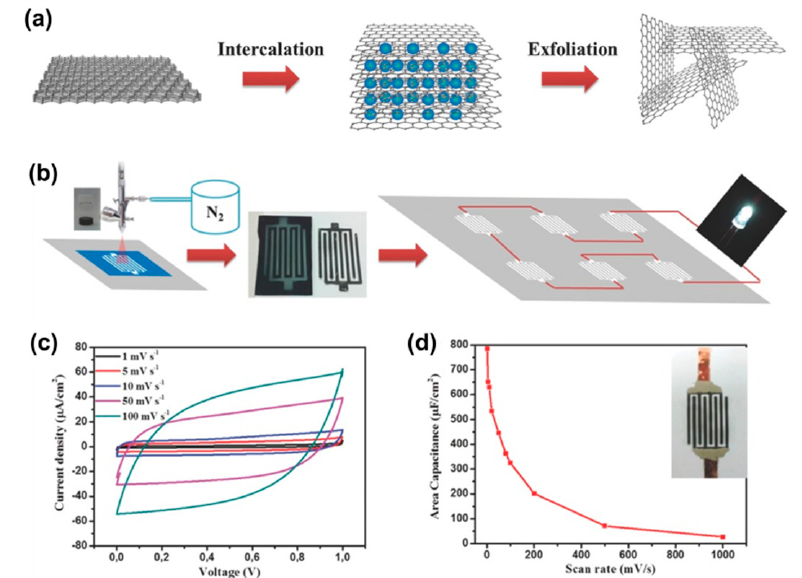
Figure 6. ( a ) Schematic illustration of the electrochemical exfoliation of graphene, ( b ) schematic illustration of the direct printing of single and arrayed micro-supercapacitor devices, ( c ) cyclic voltammetry curves of a printed micro-supercapacitor on a paper substrate, ( d ) the evolution of areal capacitance versus scan rate. Reproduced with permission from Reference [111]. Copyright © 2016 Wiley.